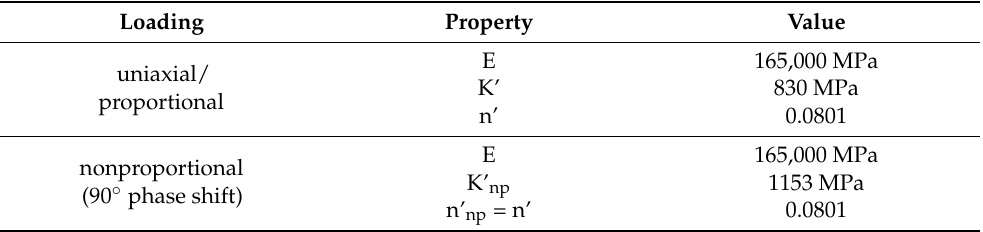
Table 3. Cyclic properties according to Ramberg and Osgood for uniaxial and nonproportional (90 ◦ phase shift)